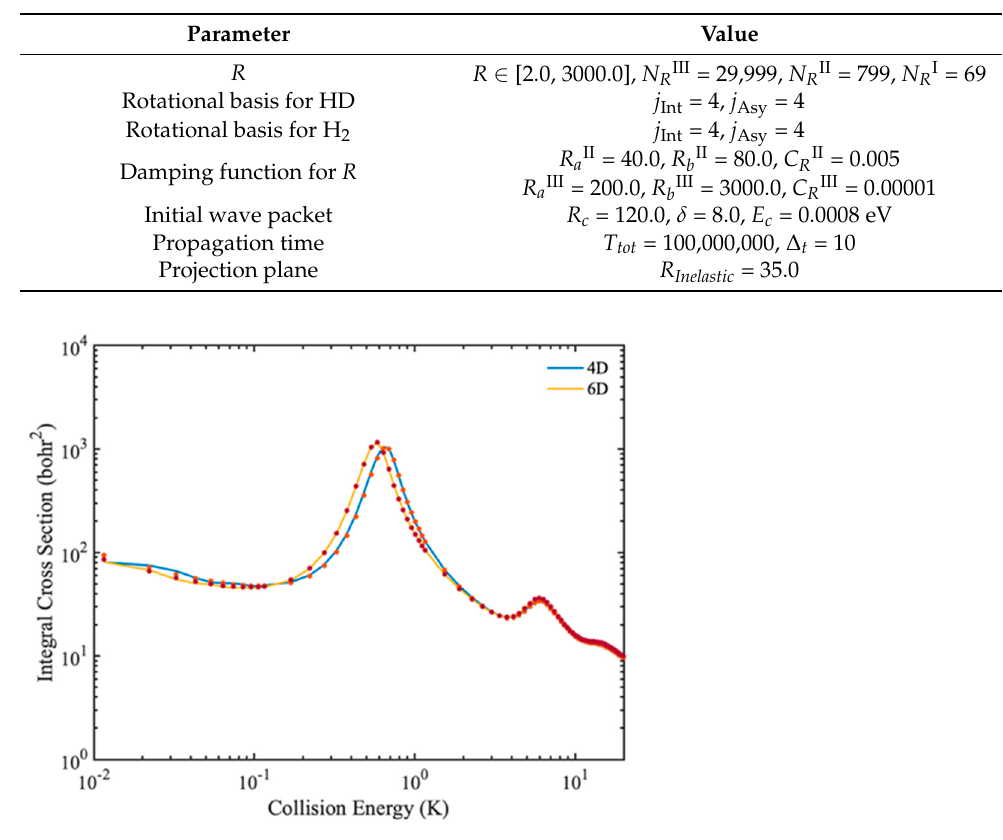
Figure 8. Comparison of rotational quenching ICSs of HD( v = 0, j = 1) + H 2 ( v = 0, j = 0) → HD( v = 0, j = 0) + H 2 ( v = 0, j = 0) collision calculated by 4D and 6D models. The solid and dot lines are obtained by IALR-WP method and TICC method, respectively.